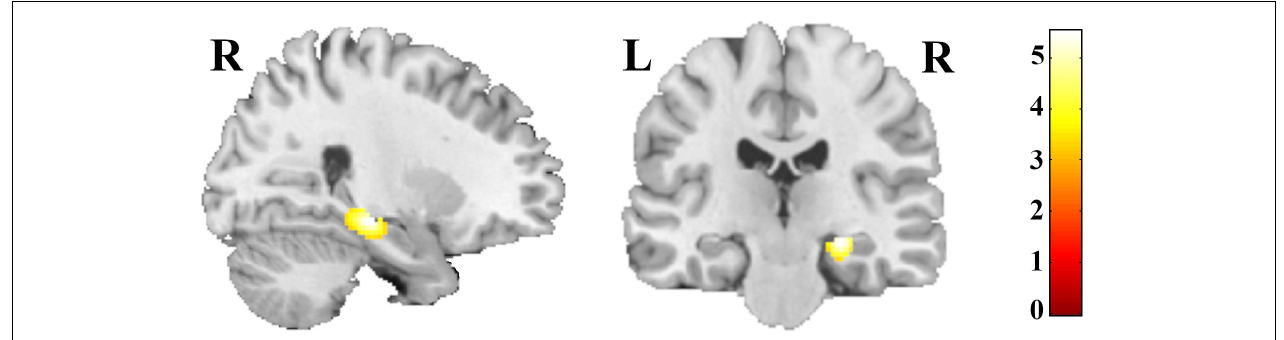
FIGURE 1 | Regions with differences in GM volume in summer- and winter-born patients with depression, schizophrenia and healthy controls; for illustration purpose threshold was set at p < 0.001, cluster sizes: k > 50 voxels; uncorrected.